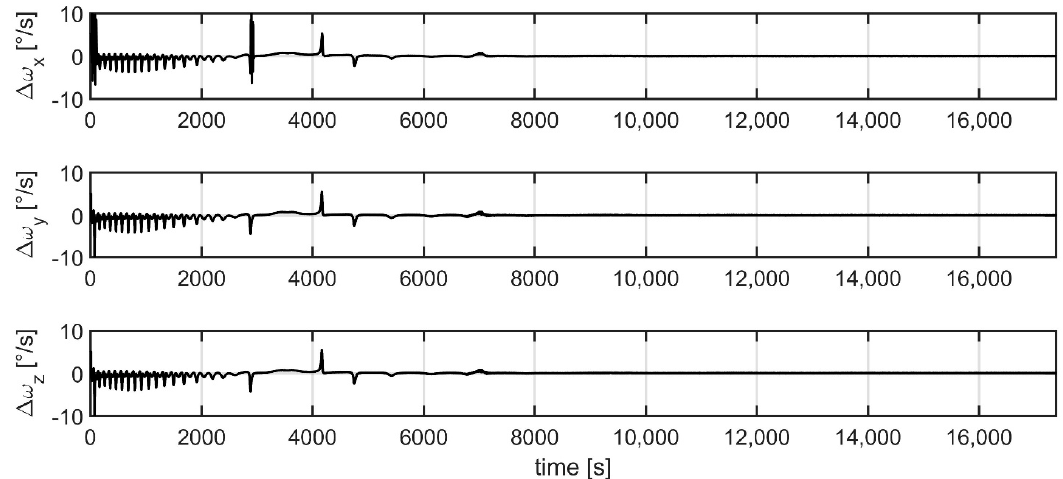
Figure 13. Di ff erence between the actual and estimated angular rates for Hardware-in-the-Loop Figure 13. Difference between the actual and estimated angular rates for Hardware-in-the-Loop simulation of Test Case 1 in the range ± 10 ◦ / simulation of Test Case 1 in the range ± 10°/s. Table 11. Root Mean Square of angular rates estimation error and settling times for Hardware-in-the- Loop simulation of Test Case 1.